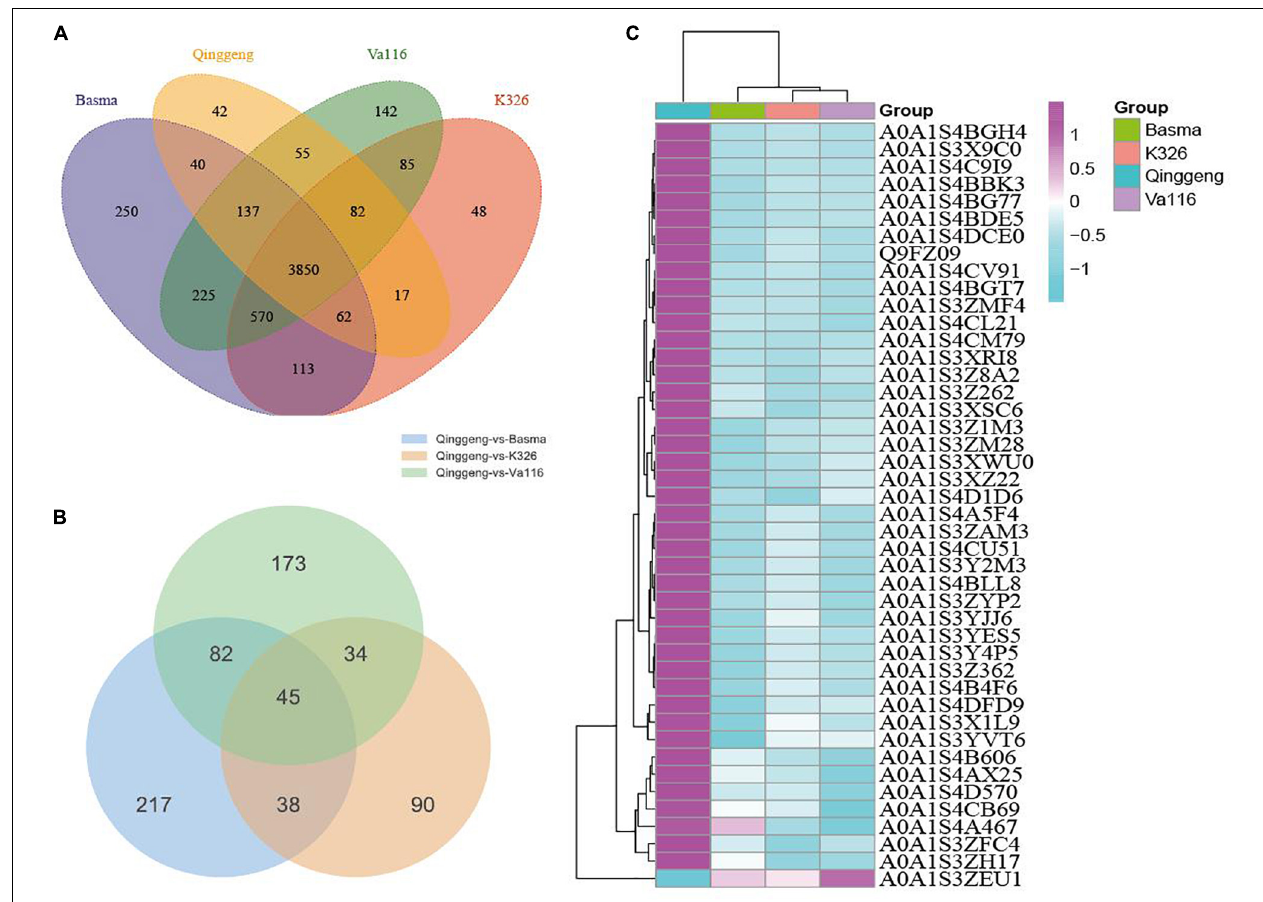
FIGURE 3 | The differentially expressed protein (DEP) profiles. (A) Venn diagram of DEPs between the four tobacco varieties. (B) Venn diagram of DEPs in the comparison groups Qinggeng vs. Basma, Qinggeng vs. Va116 and Qinggeng vs. K326. (C) Hierarchical cluster analysis of DEPs among the